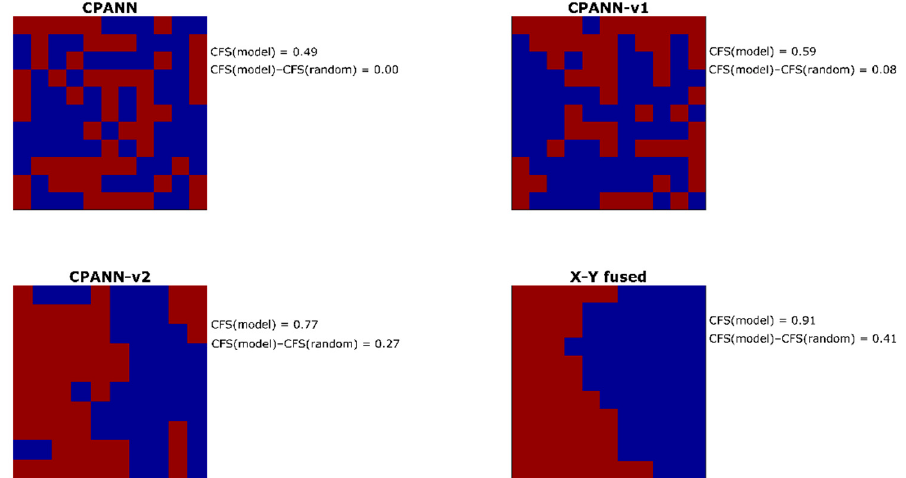
Figure 2. Response surfaces of selected models obtained from optimizations with initial 268 descrip- tors in sets. Red color indicates hepatotoxic prediction and blue color indicates non-hepatotoxic prediction of the models.